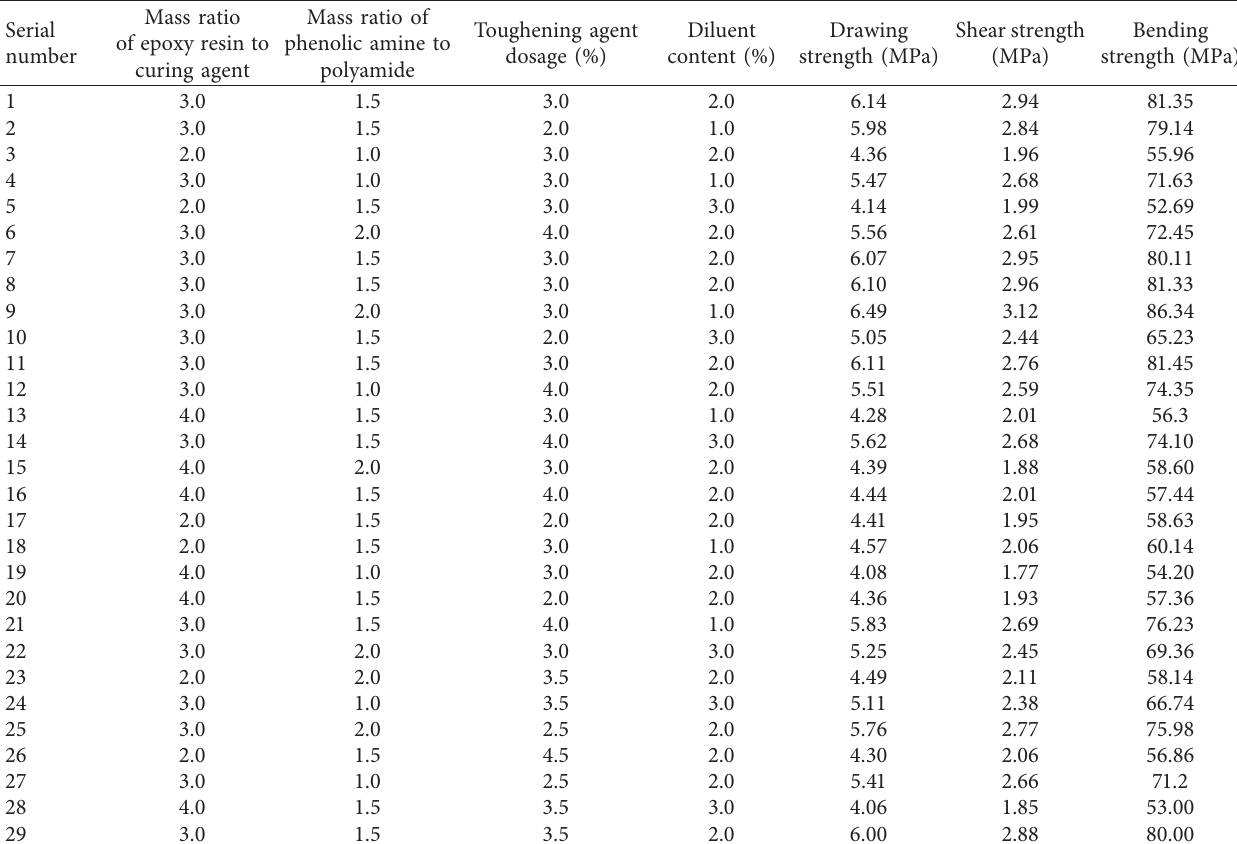
Table 5: Response surface experimental results.